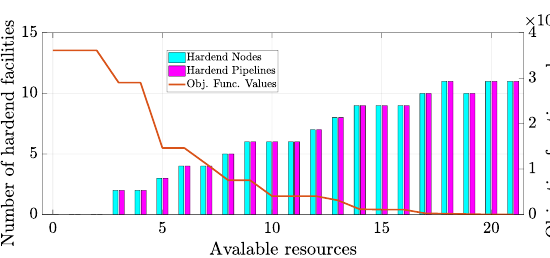
Figure 3. Network Representation.